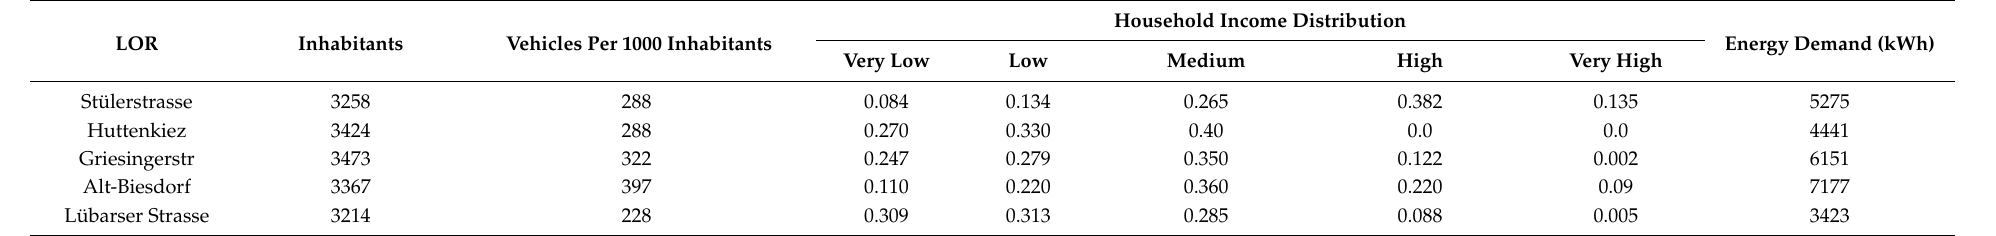
Table 5. Influence of the household income distribution, the amount of inhabitants, and the amount of vehicles in the LORs on the BEV charging energy demand on a working day